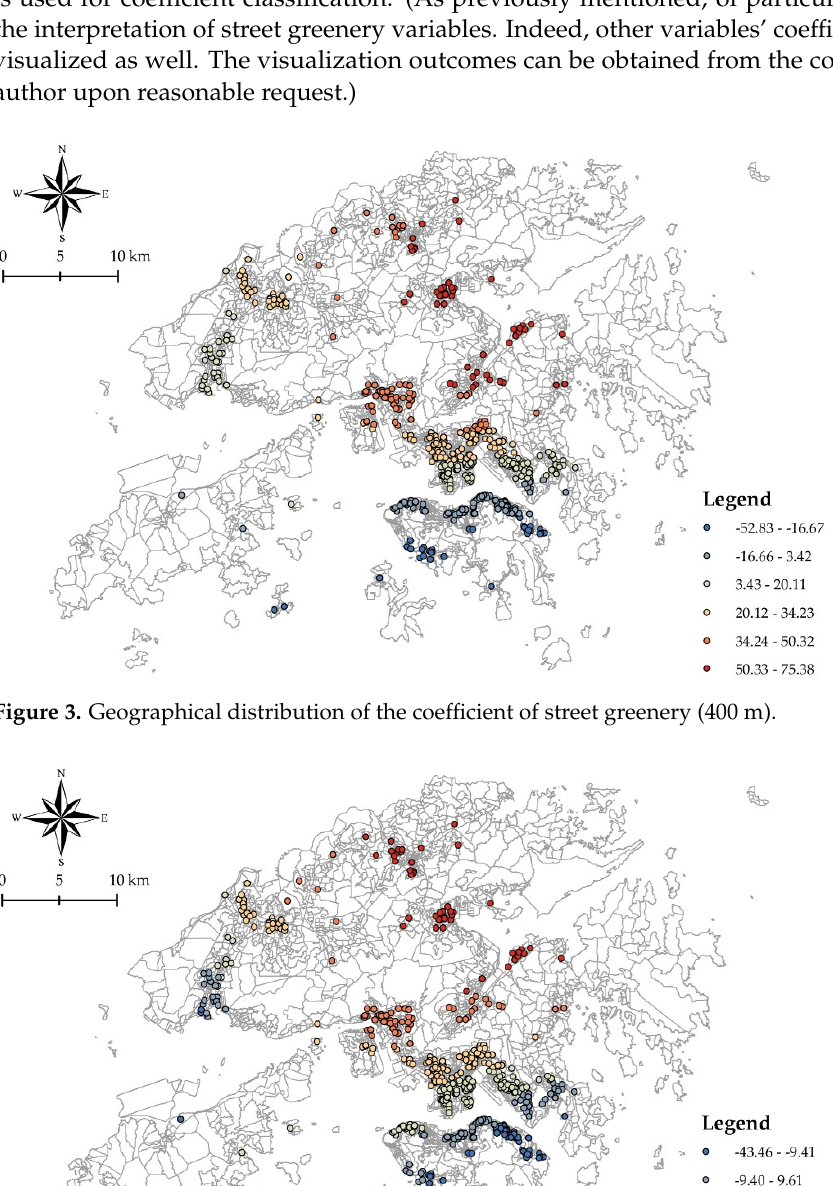
Figure 5. Geographical distribution of the coefficient of street greenery (1600 m). 6. Discussion 6.1. Implications for Research Notably, this study exclusively uses GSV data to estimate the green view index be- cause its main focus is street greenery, a hypothesized essential and easily perceived con- tributor to older adults’ walking time (partially due to biophilia, people’s innate affinity). Hence, this study exclusively detects and extracts visual features (specifically, greenery) from street view imagery. However, street view imagery has considerably greater poten- tial to represent the urban physical environment. As Kang et al. [14] suggest, by using street view imagery data, we can objectively represent the “elements” and “scenes” of the built environment. The former provides low-level semantic information, whereas the lat- ter offers high-level information. Other than greenery, more visual features can be de- tected and extracted from street view imagery at the element level. Such features include but are not limited to the sky, water bodies, traffic signs, smoke-free signage, and zebra